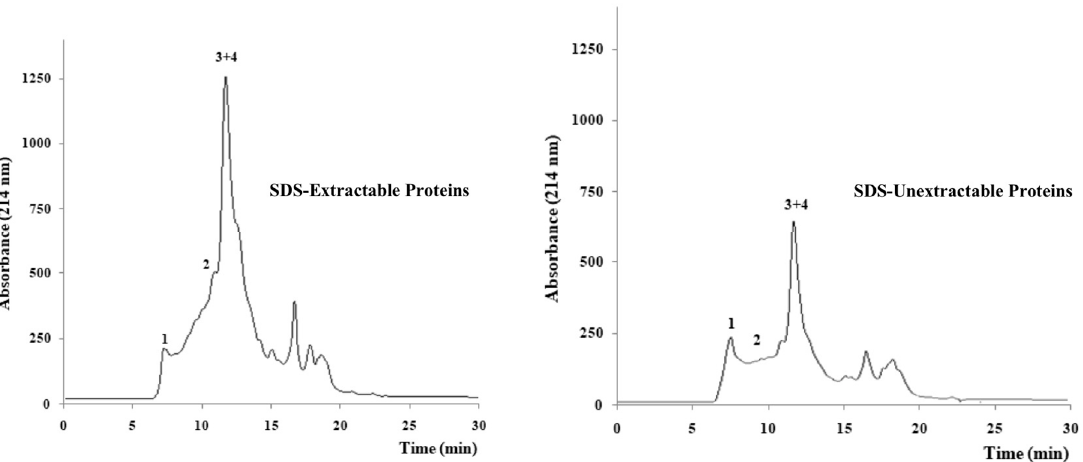
Figure 2. Chromatographic profiles of SDS-Extractable and SDS-Unextractable proteins of Em-D spent grains: peak 1, Large Polymeric Proteins (LPP); peak 2, Small Polymeric Proteins (SPP); peak 3 and 4, Large Monomeric and Small Monomeric Proteins (LMP +